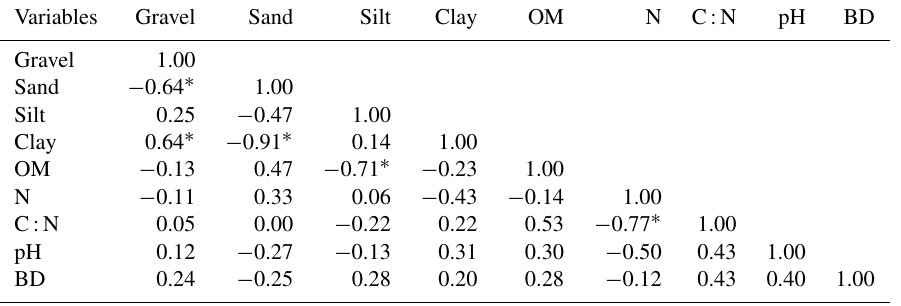
Table 4. Spearman correlation matrix for relationships between selected soil parameters in the study area. Variables Gravel Sand Silt Clay Gravel